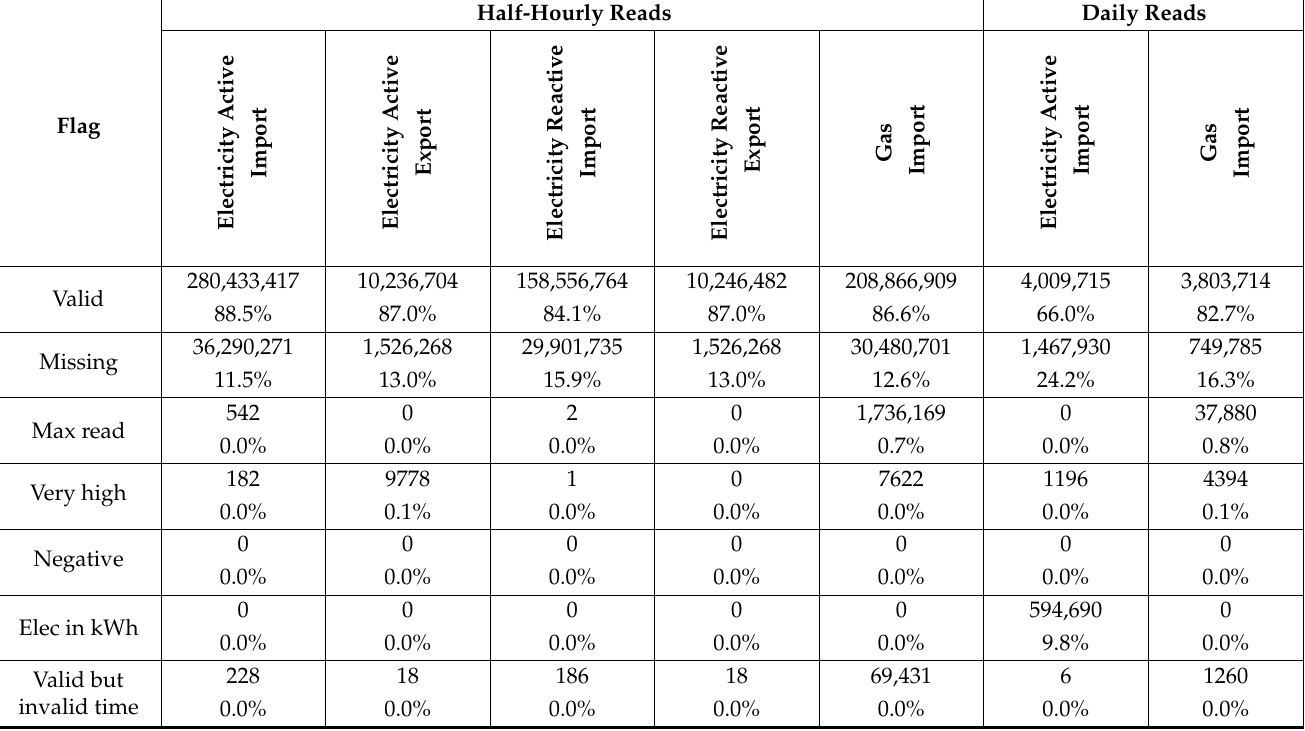
Table 4. Smart meter error flag prevalence by read